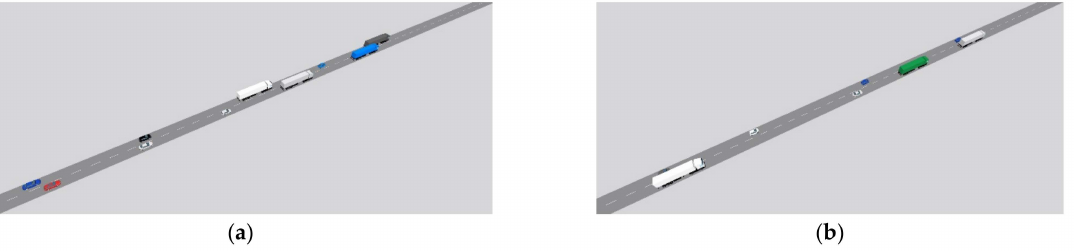
Figure 6. Example of uniform traffic flow distribution across traffic lanes: ( a ) NB_ scenario; ( b ) WB_